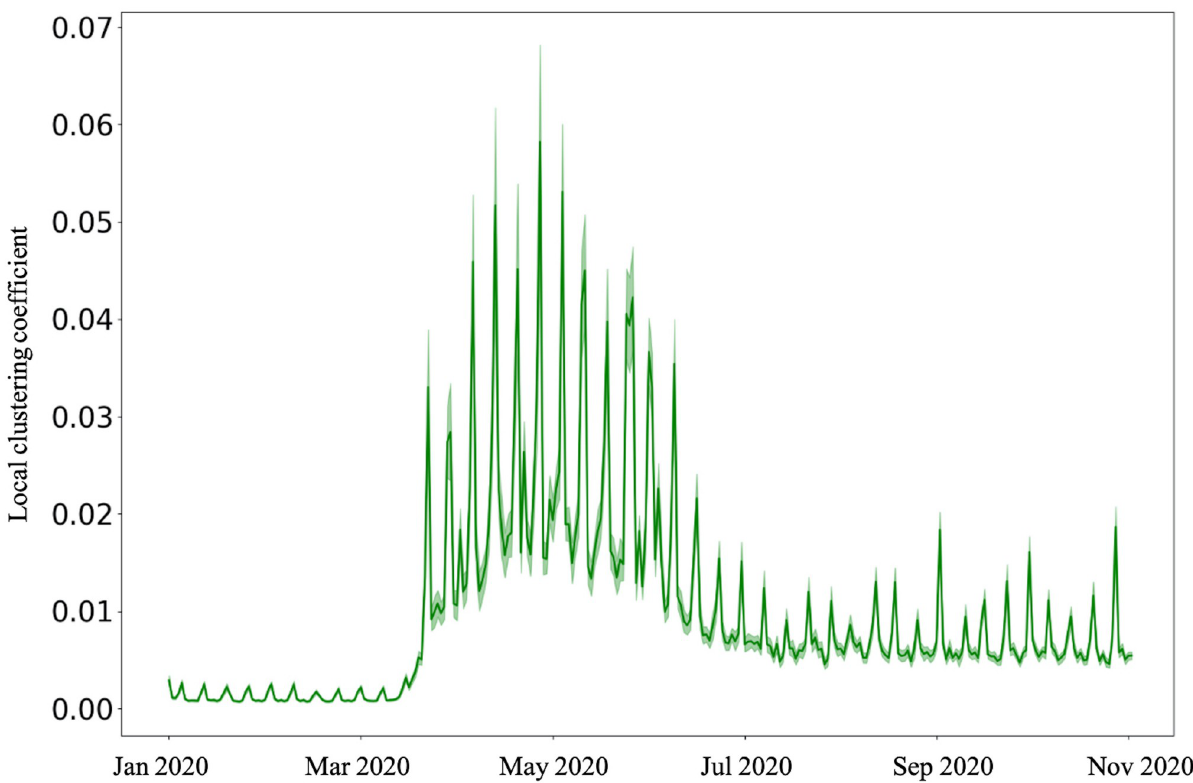
Fig 4. The weighted clustering coefficient increases with fluctuations attain a peak by about May 01, 2020, and decreases to a stable value from July 2020.